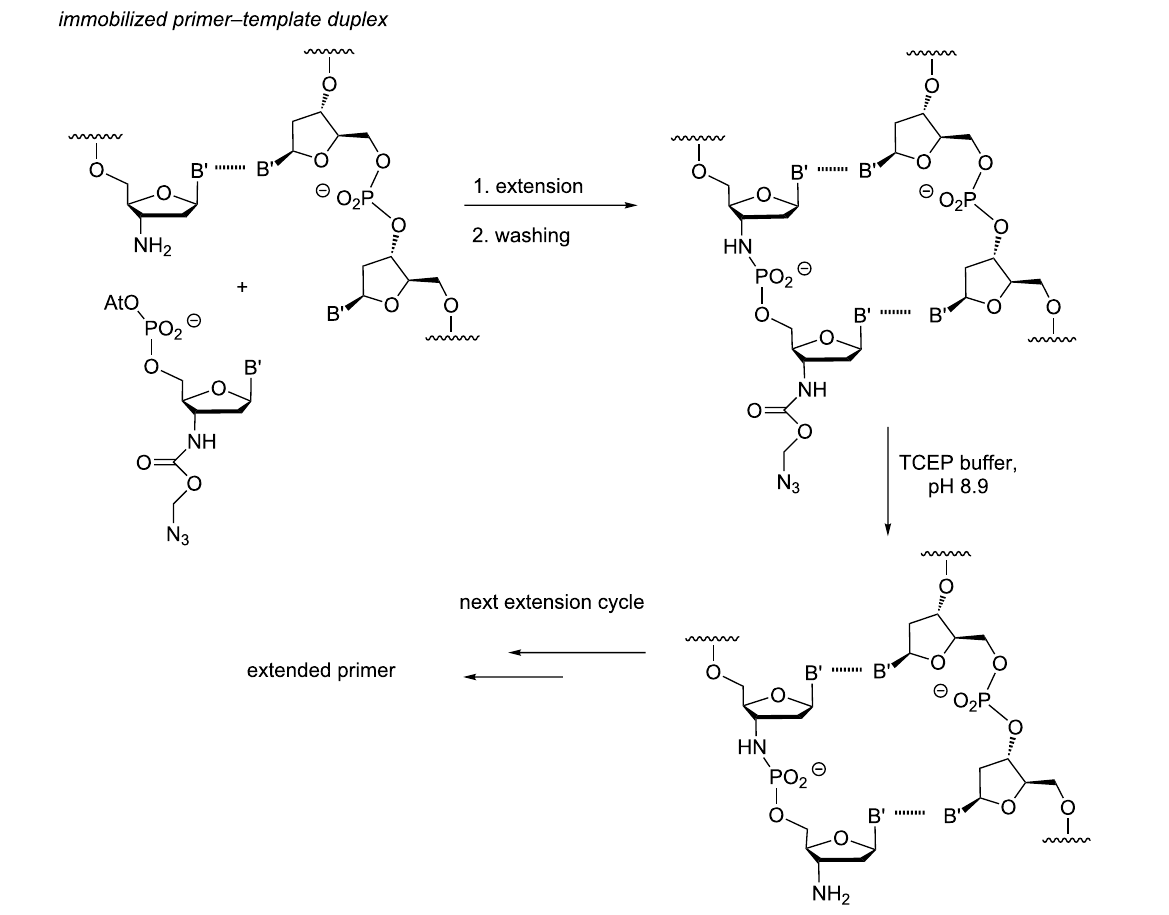
Figure 11: Extension cycle of aminoterminal primer with N-protected nucleotides on solid support, as described by Kaiser et al.